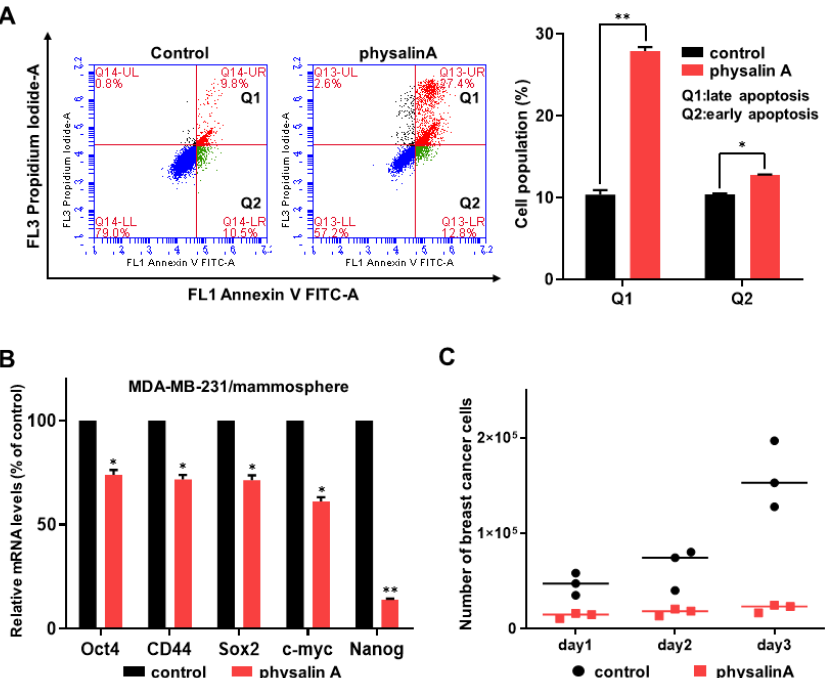
Figure 3. Effects of physalin A on apoptosis of mammospheres, expression of cancer stem cell markers, and mammosphere growth. ( A ) Physalin A increased apoptotic subpopulation of mammospheres. Mammospheres were cultured in an ultralow attachment 6-well plate for 5 days and then treated with/without physalin A for 2 days. Subsequently, the cells were collected and trypsinized to obtain single cells and washed with 1X PBS. 1 × 10 5 single cells were counted and suspended with 100 µ L of 1X Annexin V binding buffer. 5 µ L of FITC Annexin V solution and 5 µ L of PI staining solution were added to each cell. All samples were incubated for 15 min at room temperature. After washing with 1X Annexin V binding buffer, cell pellets were suspended with the buffer. Apoptosis was assayed by Annexin V/PI staining using an Accuri C6 flow cytometer (BD, San Jose, CA, USA). ( B ) Transcriptional levels of CSC markers, such as Oct4 , CD44, Sox2, c-myc , and Nanog genes were determined in mammospheres treated with/without physalin A using CSC marker-specific primers and real-time qPCR (Table S1). β -actin was used as an internal control. ( C ) Mammosphere growth is decreased by physalin A. MDA-MB-231 mammospheres treated with/without physalin A were suspended with a single cell, and the single cells were cultured in equal numbers in 6 cm diameter dishes. One to three days later, the cells were counted. Mean ± SD values from three independent experiments are presented. * p < 0.05, ** p < 0.01 vs. DMSO-treated control.